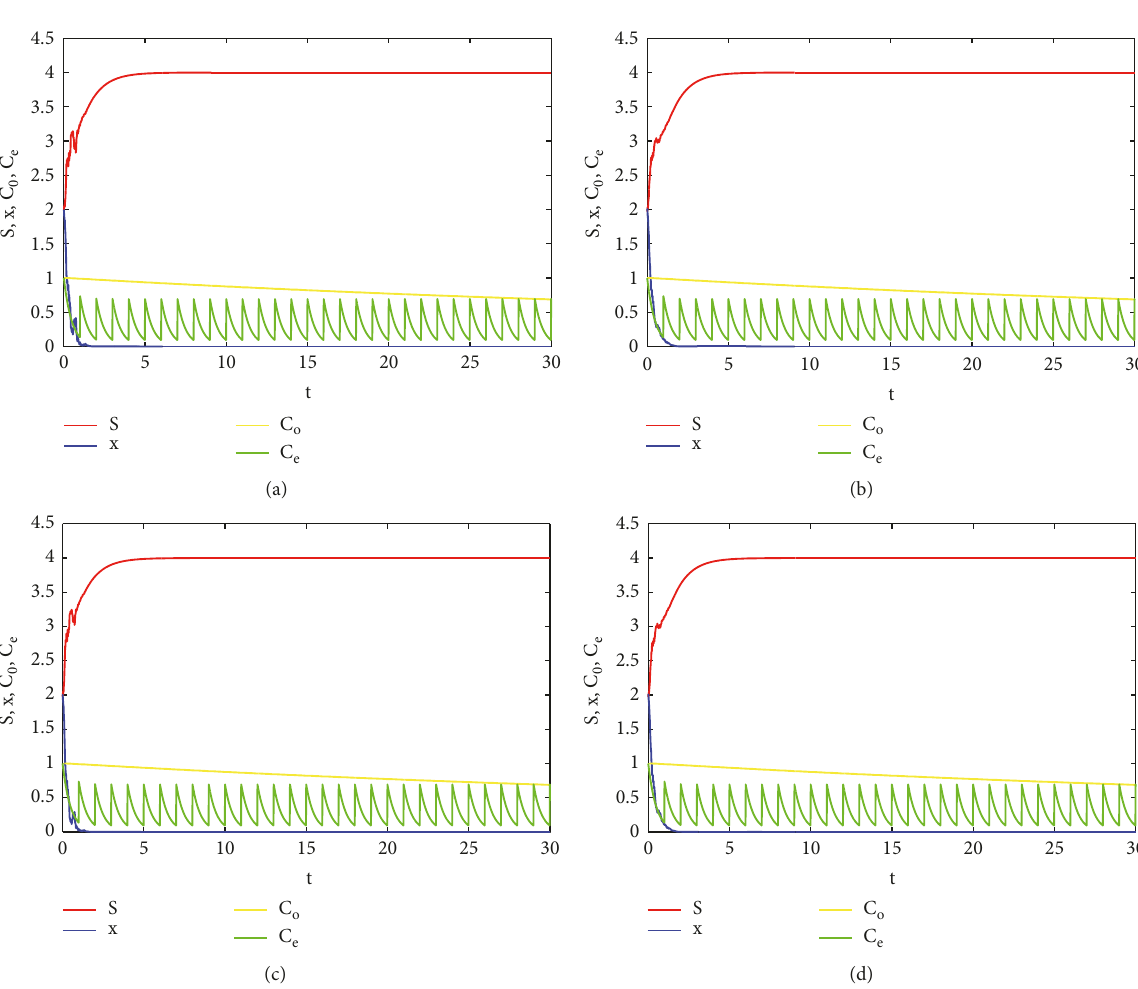
Figure 1: The solution of system (2) for extinction of the